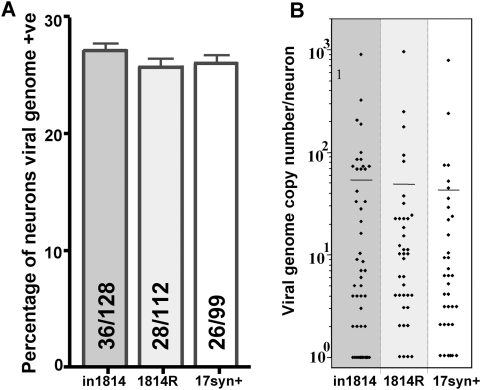
Mutant in1814 establishes latency as efficiently as genomically wild
type isolates.Groups of mice were infected with strain 17Syn+, in1814, and the
genomically rescued variant 1814R, as described in Methods. At 40 days pi, the ganglia of 3 mice per
group were processed for single neuron PCR. Individual neurons were
examined for the presence of the viral genome and the number of viral
genomes present in positive neurons was determined using a quantitative
PCR assay as detailed in Methods.
(A) Shown is the percentage of neurons positive for the viral genome.
The number of neurons positive for the viral genome over the number
tested is shown in the histograms. (B) Each point on the scattergram
represents the number of viral genomes present in an individual neuron.
The horizontal bars are drawn at the mean value of genome copies per
positive neuron.